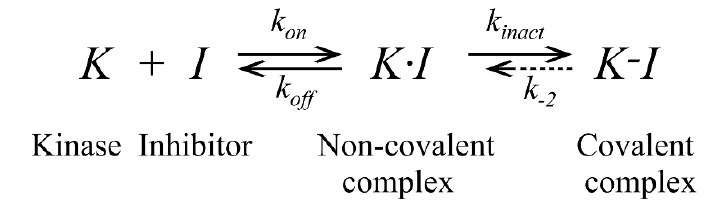
Figure 2. Warheads present in available covalent kinase inhibitors. Warheads are grouped based on different targeted amino acids. The dashed rectangle shows the warheads found in reversible